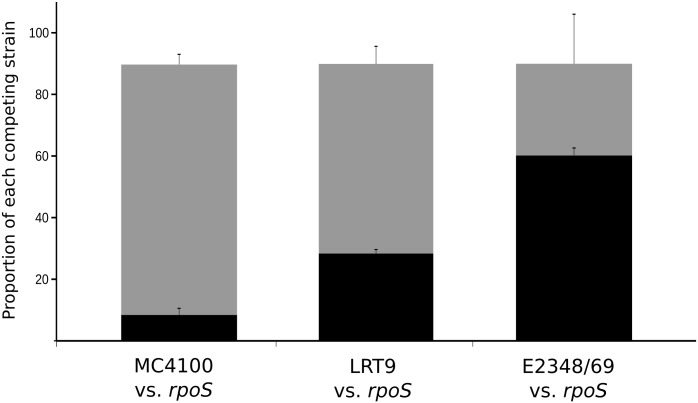
Effect of rpoS on EPEC fitness.MC4100, LRT9, E2348/69 were mixed at 1:1 ration with their respective rpoS∷Tn10 mutants and grown for 24 hours in a chemostat with minimal medium containing 0.2% glucose and 30 μM KH2PO4 at a dilution rate of 0.1 h-1. Samples were removed, diluted and plated on L-agar supplemented or not with tetracycline for CFU determination. Black color, wild-type strains; grey color, rpoS∷Tn10 mutants. Bars represent the mean ±SEM of three independent competitions.